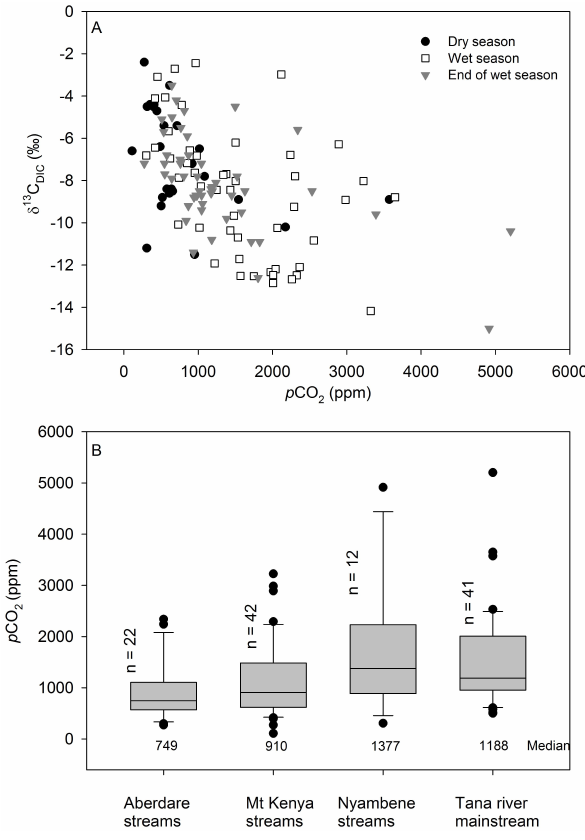
Fig. 6. (A) Plot of δ 13 C DIC vs. p CO 2 along the Tana River basin, (B) Boxplots of p CO 2 along the Tana River basin. The centre line, box extent, error bars, and dots denote the 50th percentile, 25th and 75th percentiles, 10th and 90th percentiles, and outliers of esti- mates,